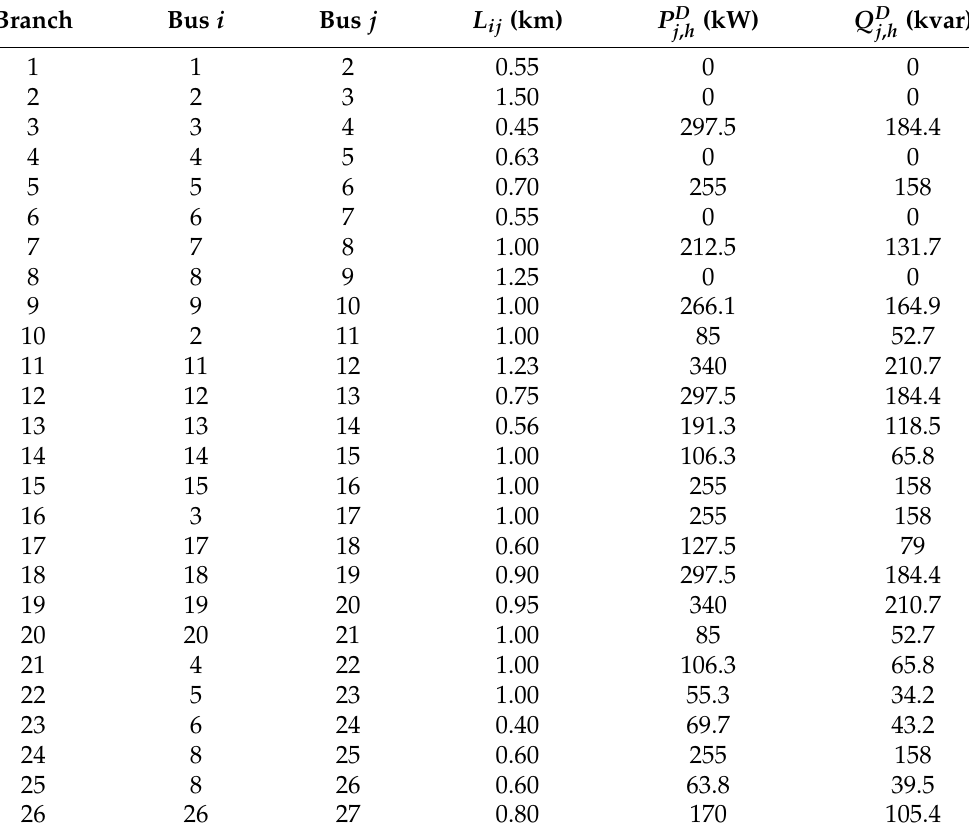
Table 7. Parametric information of the 27-bus test feeder for the balanced case.